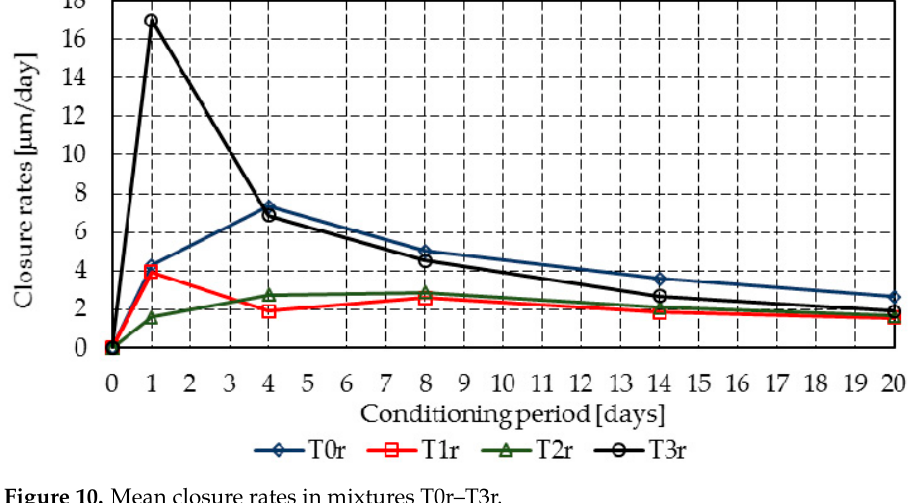
Figure 10. Mean closure rates in mixtures T0r–T3r.